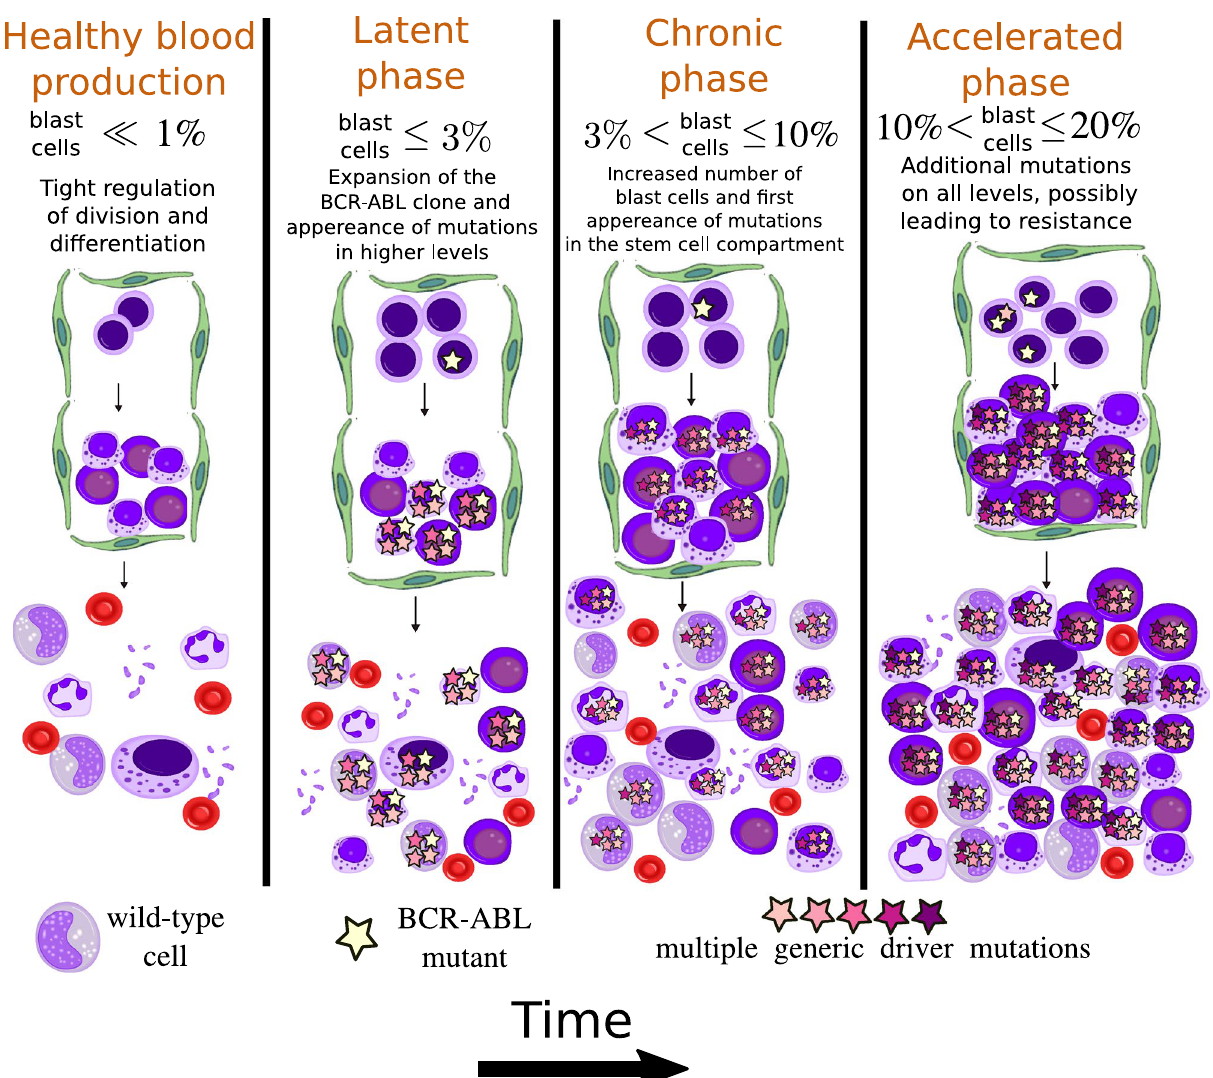
Figure 1. Qualitative description of CML progression. In healthy blood production with tightly regulated cell production, HSCs in the bone marrow (area surrounded by the green barrier) produce mature cells, which are released into the bloodstream (downwards). During the latent phase the BCR::ABL1 clone grows, increasing the blast percentage in the bloodstream. In the chronic phase, the blast percentage increases, and the first generic driver mutations begin to appear. The accelerated phase is an intermediate phase, characterized by the accelerated growth of the blast percentage in the bloodstream, leading to the exponentially growing blast phase. This figure has been adapted from the original By A. Rad and M. Häggström. https:// en. wikip edia. org/ wiki/ Haema topoi esis CC-BY-SA 3.0 license, used with